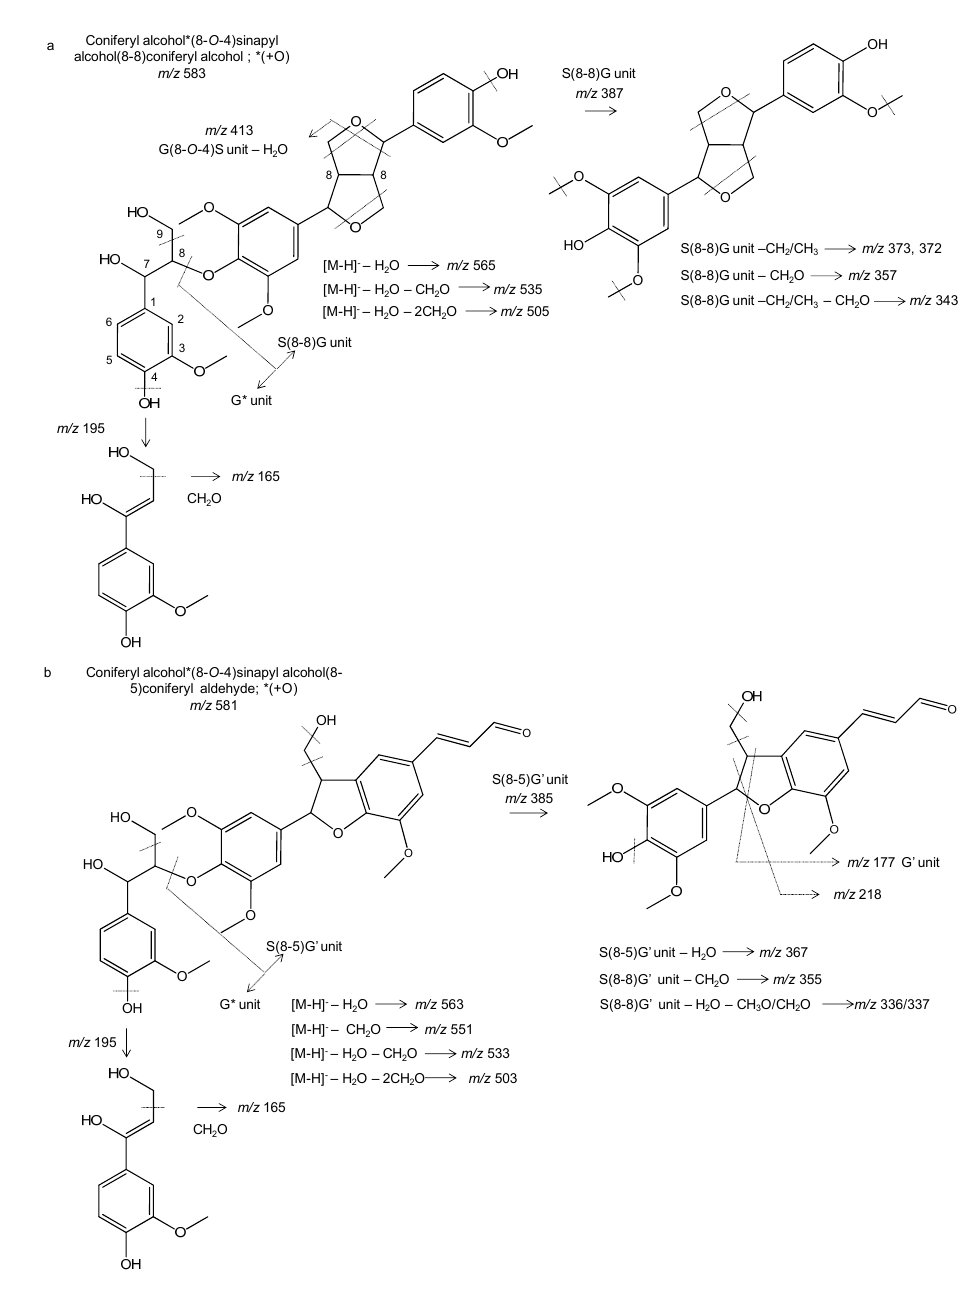
Figure 3. Tentative structure of novel free trilignols, ( a ) at m/z 583, ( b ) m/z 581 and derivatives characterized by mass spectrometry in olive byproducts.